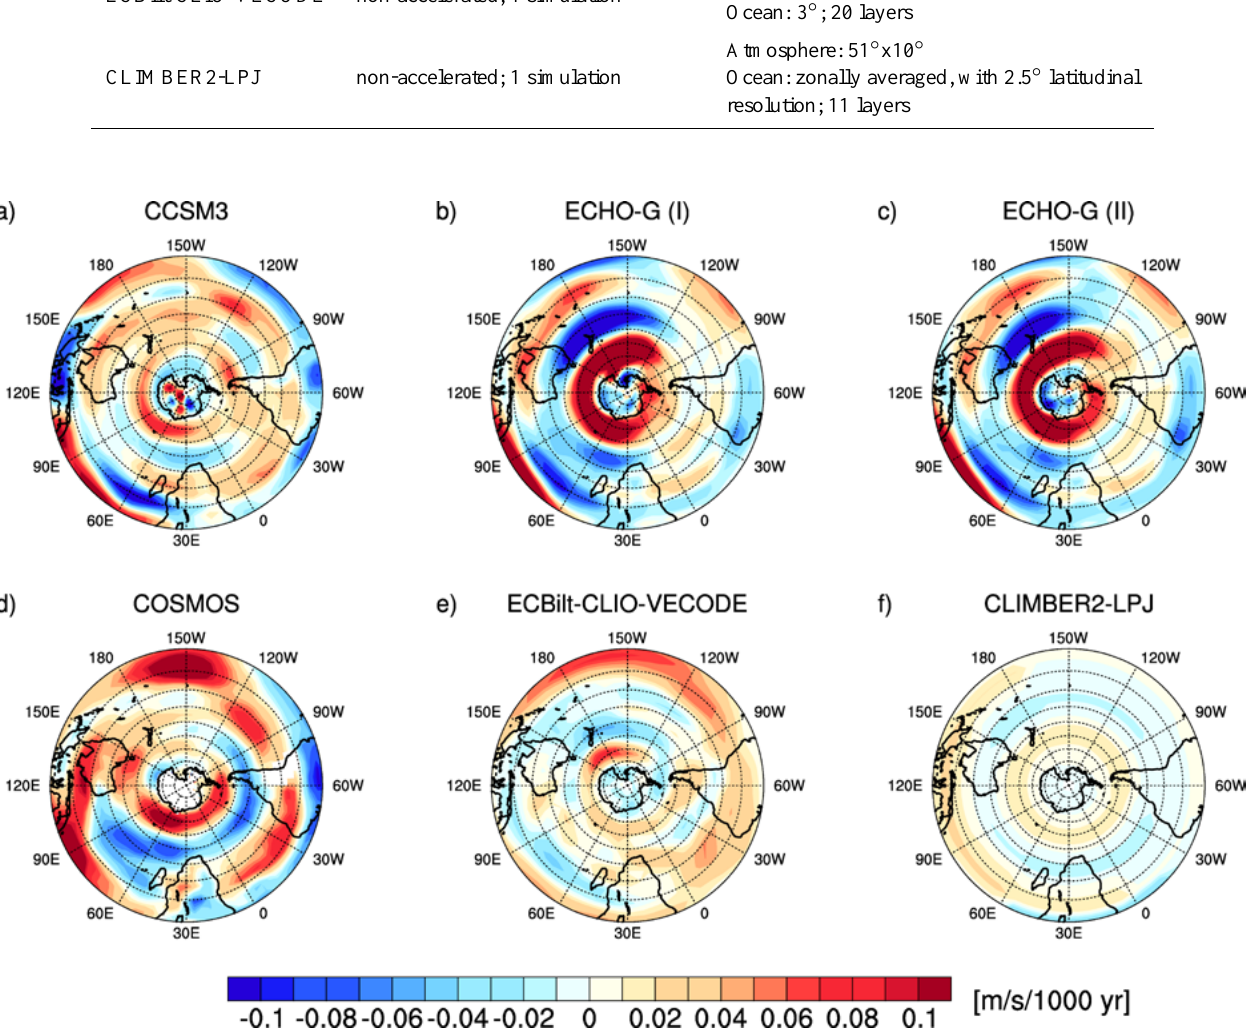
Fig. 3. Trend in the annual-mean low-level zonal wind in (a) CCSM3, (b) ECHO-G (I), (c) ECHO-G (II), (d) COSMOS, (e) ECBilt-CLIO- VECODE, and (f) CLIMBER2-LPJ for the period 7kyr BP to 250yr BP. All polar stereographic plots represent the Southern Hemisphere, with latitudes placed at 10 ◦ intervals, starting from the equator to 90 ◦